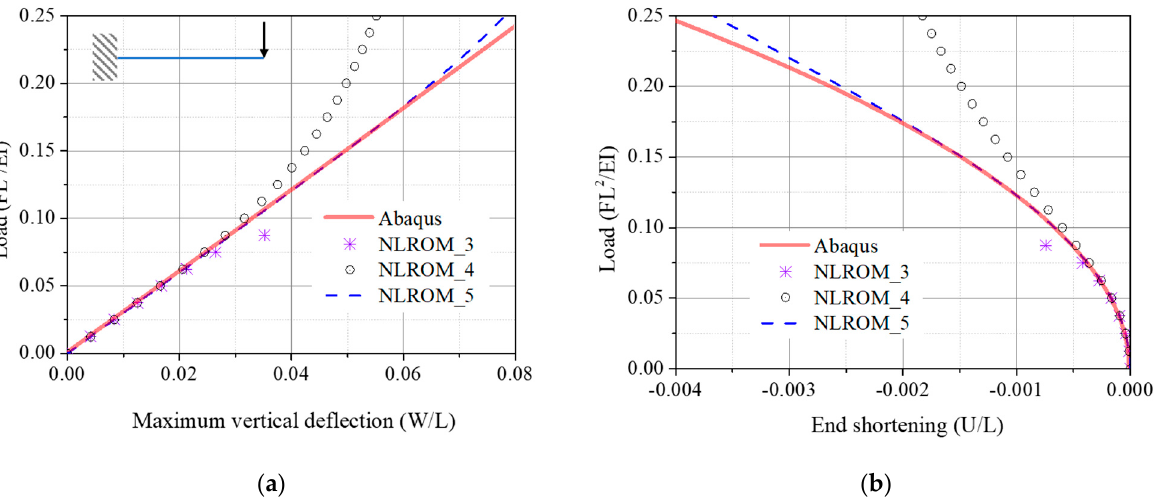
Figure 11. Static displacement at the free end of the cantilever beam: ( a ) Vertical deflection; ( b ) End shortening. (NLROM_3: f in = K (1) q + K (2) qq + K (3) qqq ; NLROM_4: f in = K (1) q + K (2) qq + K (3) qqq + K (4) qqqq ; NLROM_5: f in = K (1) q + K (2) qq + K (3) qqq + K (4) qqqq + K (5) qqqqq ).